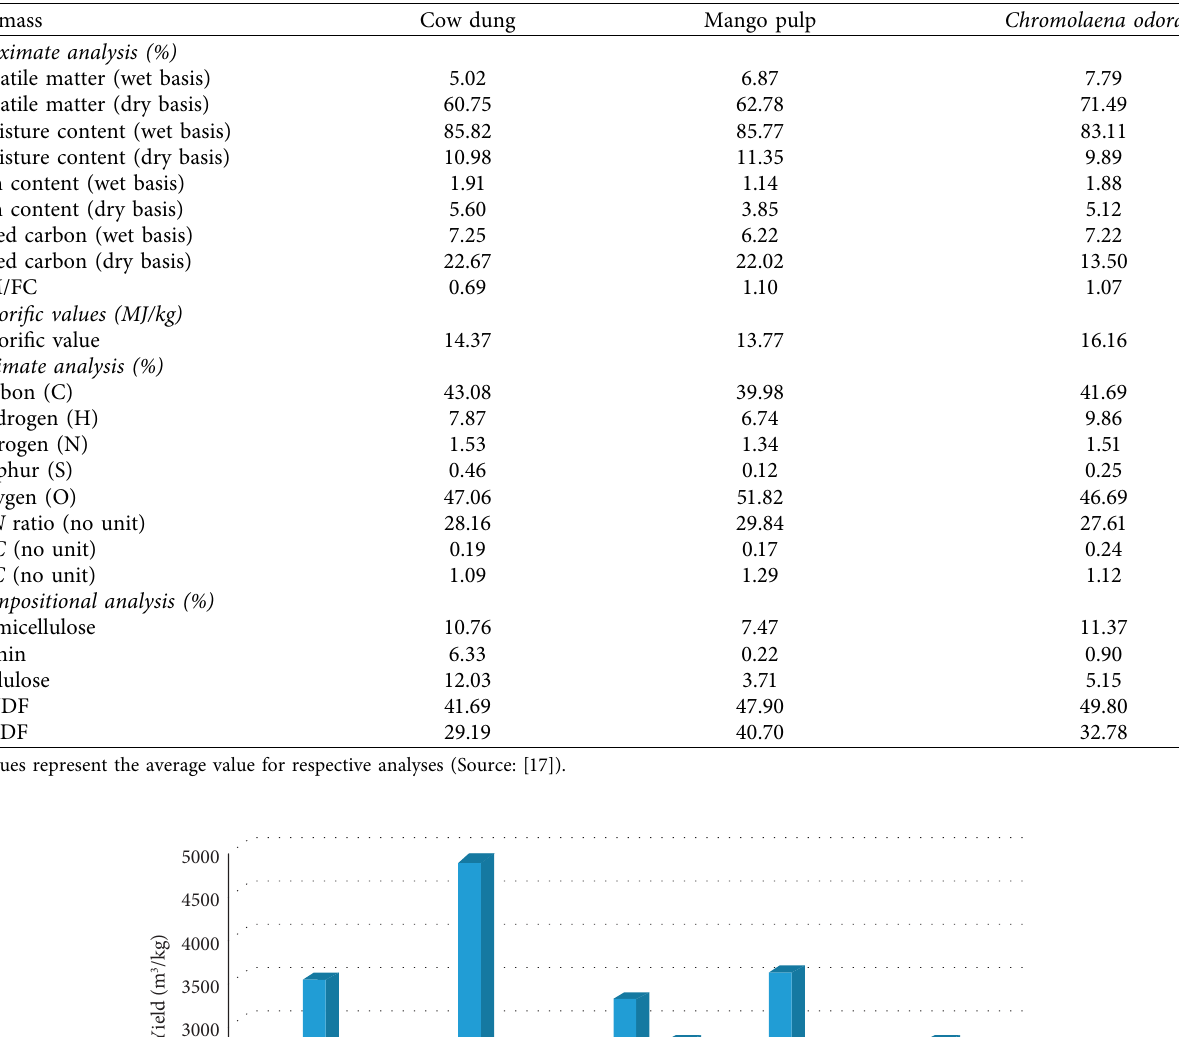
Table 3: Biomass characterization.